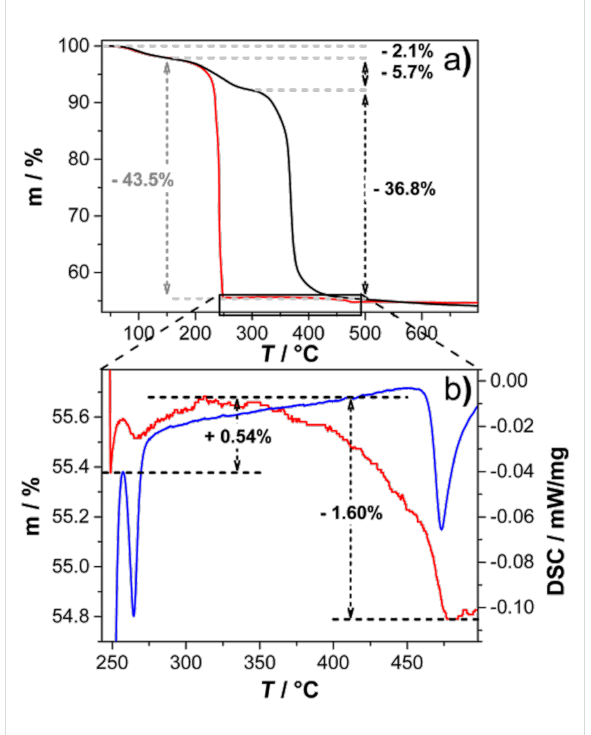
Figure 6: a) TGA measurements recorded while heating the Mn(II) glycolate precursor up to 700 °C at 2 K/min in an Ar (black) and an O 2 /Ar (1:2) (red) flow of 40 NmL/min; b) detailed view of the tempera- ture range between 250 and 500 °C of the TGA (red) and DSC (blue) measurements in O 2 /Ar (1:2) flow indicating the oxidation of Mn 3 O 4 to Mn 5 O 8 and α -Mn 2 O 3 .